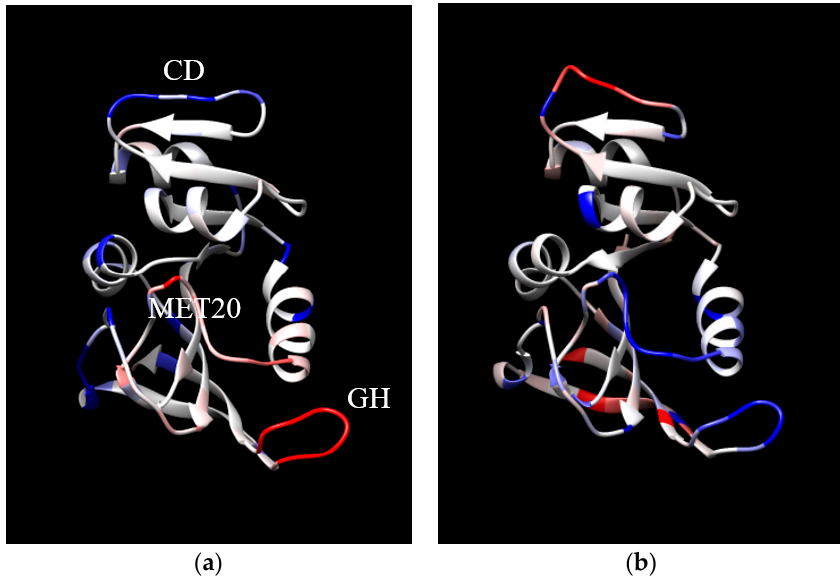
Figure 4. The difference in MSF between 1 and 220 bar at 279 K for ( a ) EcDHFR and ( b ) MpDHFR. The coloring of each residue indicates the difference in the average MSF of all heavy atoms in the residue, where the coloring scale is that –0.5 is dark blue, 0 is colored, and 2.0 is colored. Loops are identified in ( a ).